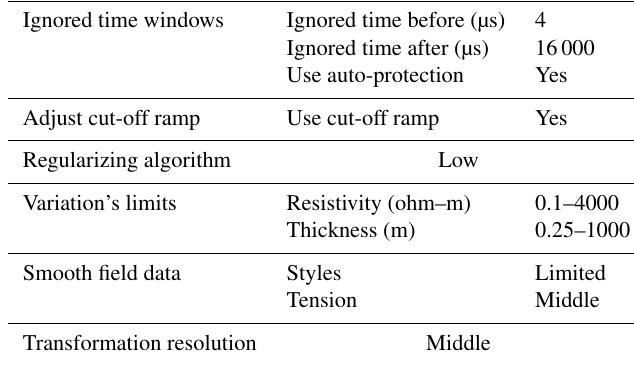
Table A8. TEM inversion